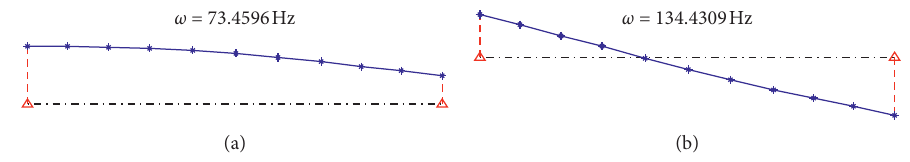
Figure 6: The first two modes and corresponding energy distribution coefficient η . (a) 1 st mode η � 88.82%. (b) 2 nd η � 92.49%.